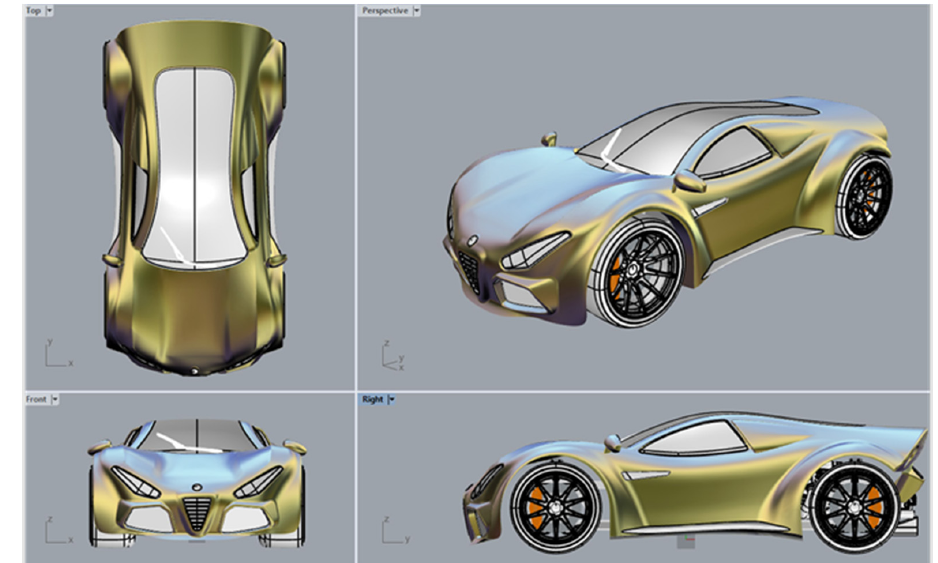
Figure 31. Natural concept 3D Modelling via McNeel Rhinoceros.